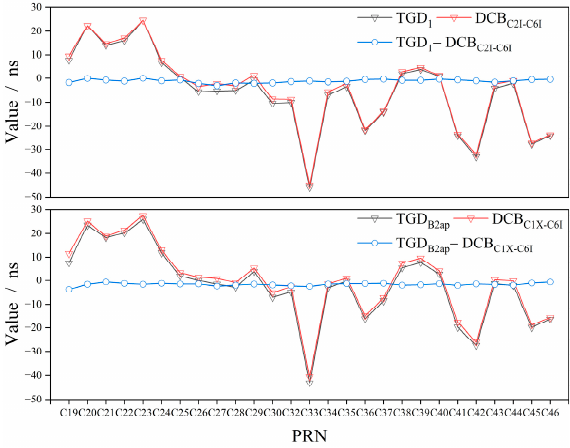
Figure 2. Difference between TGD parameters and DCB products.